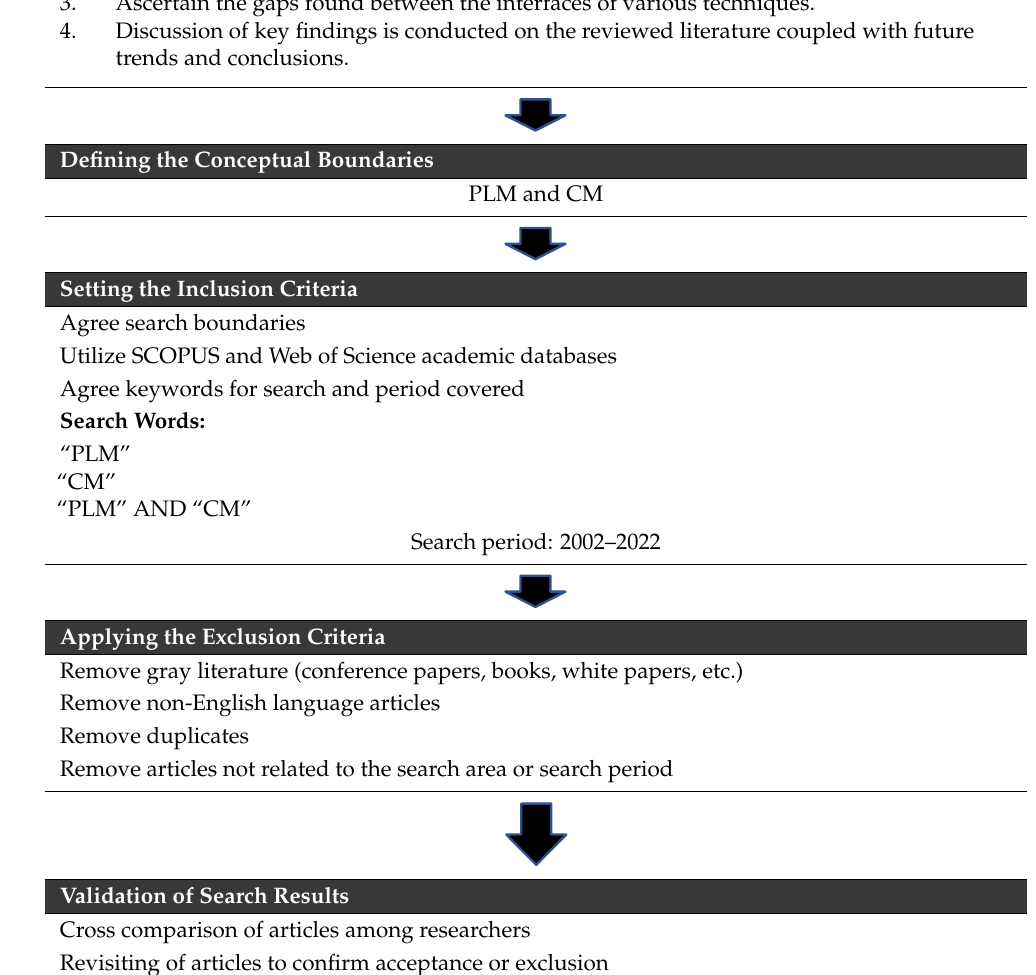
Figure 1. General Change Process Scheme (Adapted from Tavcar and Duhovnik [15]). Table 2. Literature Research Methodology Flow Chart with Inclusion and Exclusion Criteria.